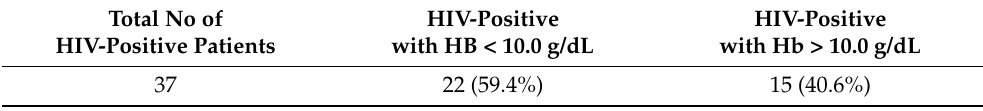
Table 7. Prevalence of anaemia in HIV-positive